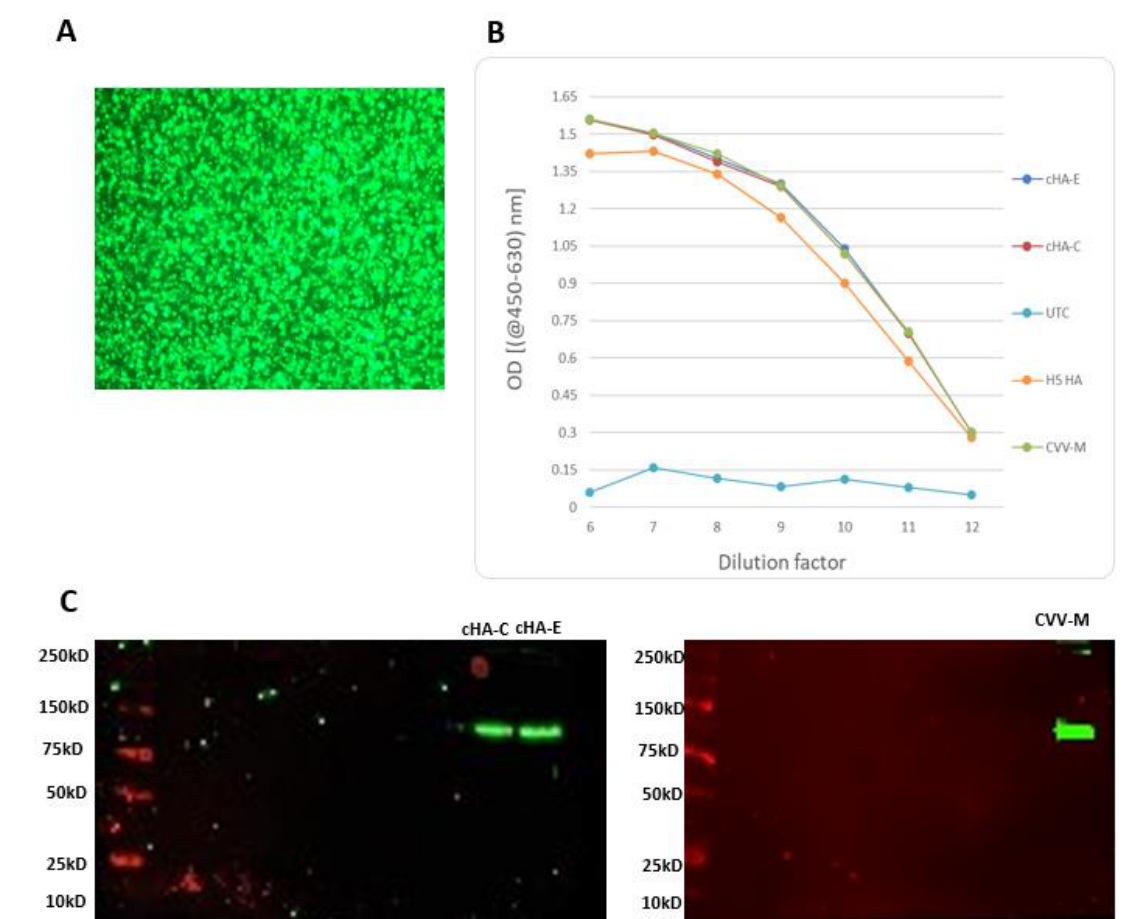
Figure 6. Confirmation of HA expression in S2 cells. Day three success of HA expression in supernatant of S2 cell culture confirmed by green fluorescent protein expression control (at a magnification of ×20) displaying about >90% transfection efficiency ( A ); ELISA, showing similar expression patterns for cHA-C, cHA-E and CVV-M controlled by an in-house H5 HA expressing-S2 cells, and supernatant from an un-transfected cell control (UTC) ( B ) or Western blotting showing blots of cHA-C, cHA-E and CVV-M at expected band sizes of approximately 75 kD ( C ).